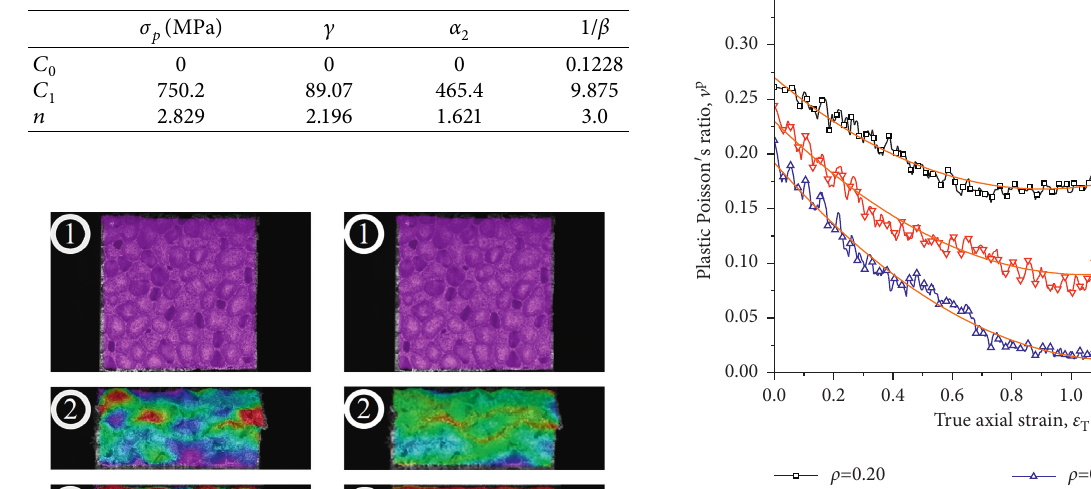
Table 4: Parameters C